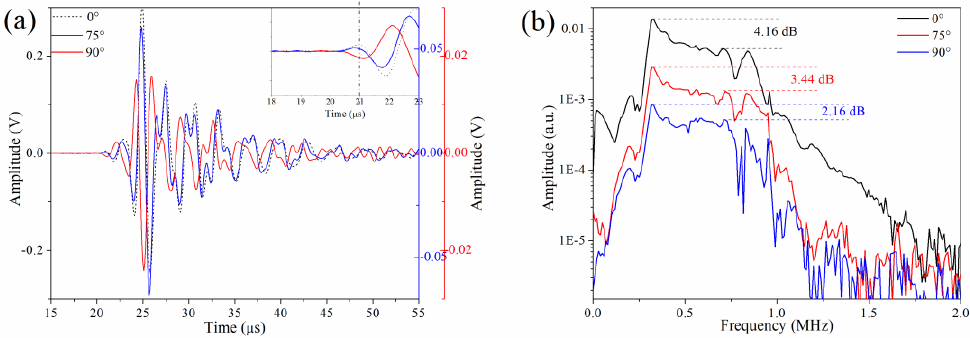
, D 75 and D 90 2 2 2